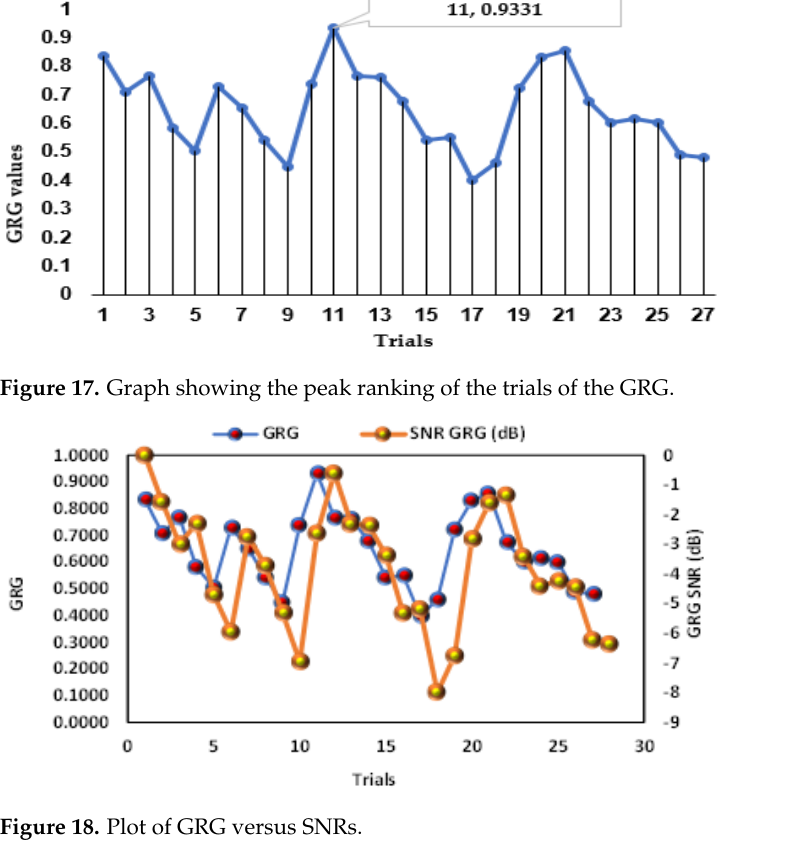
3 N − 1 m − 1 ) µ . s (mm